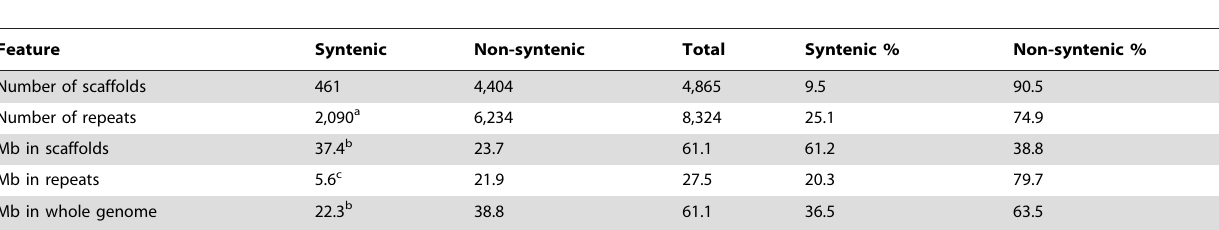
Table 4. Syntenic and non-syntenic regions between C. fulvum and D. septosporum are unevenly distributed over the C. fulvum scaffolds.